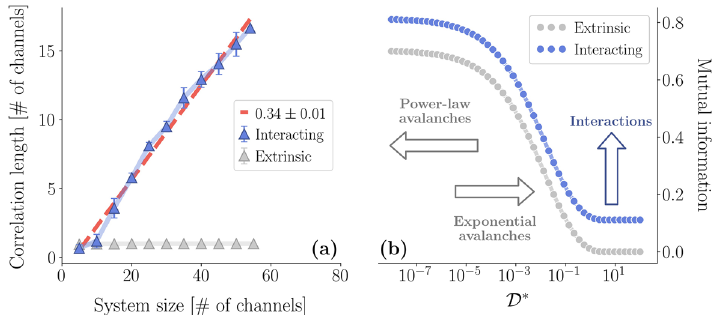
Figure 3. ( a ) The correlation length of the interacting model scales linearly with the system size, as in the data. In the extrinsic model, as expected, the correlation length of the fluctuations is constant and equal to 1, i.e., the correlation function drops to zero for adjacent electrodes. ( b ) Comparison between the mutual information in 1 , γ D 10 , γ 1 0.1 , γ 2 0.5 ) and, as an example, in the interacting model with two the extrinsic model ( θ = = = = units. Notice that the onset of a non-vanishing mutual information induced by D ( t ) is also the onset of power- law distributed avalanches, whereas the mutual information arising from interactions is independent of D ∗